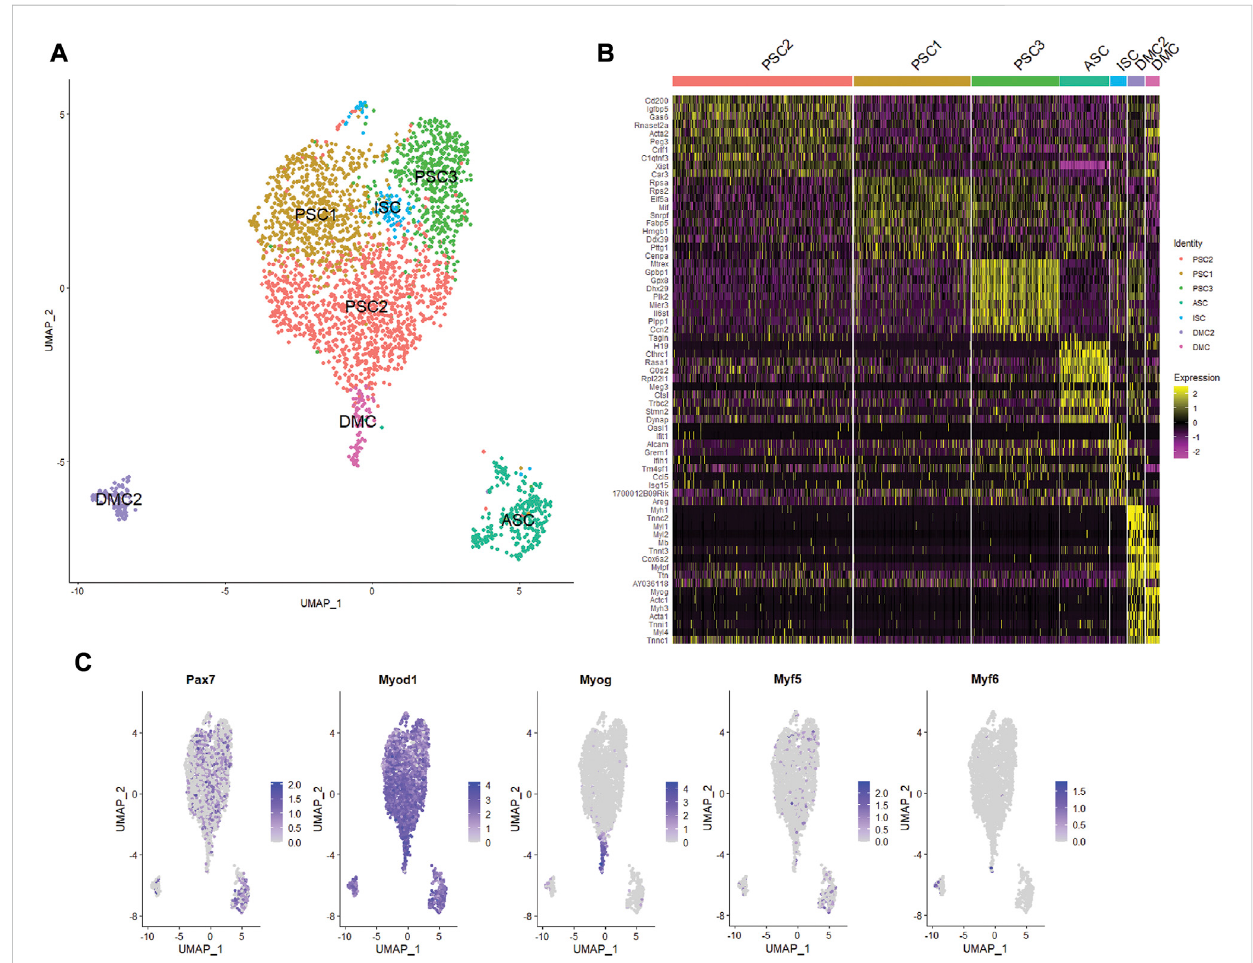
FIGURE 2 Single cell RNA-seq analysis of primary mouse MuSC culture. (A) UMAP clustering of the PBS-treated MuSCs. Cells clustered into seven groups based on differential gene transcription. (B) Heatmap depicting top 10 differentially expressed genes for each cluster. (C) Feature plots show the distribution of the myogenic transcription factors of Pax7, Myod1, Myog, Myf5, and Myf6 in the